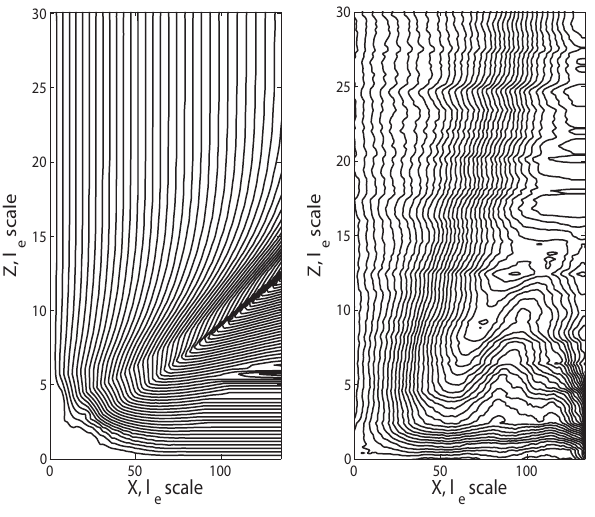
Fig. 3. Electron trajectories in XZ plane: analytical model (on the left) and PIC simulation (on the right).